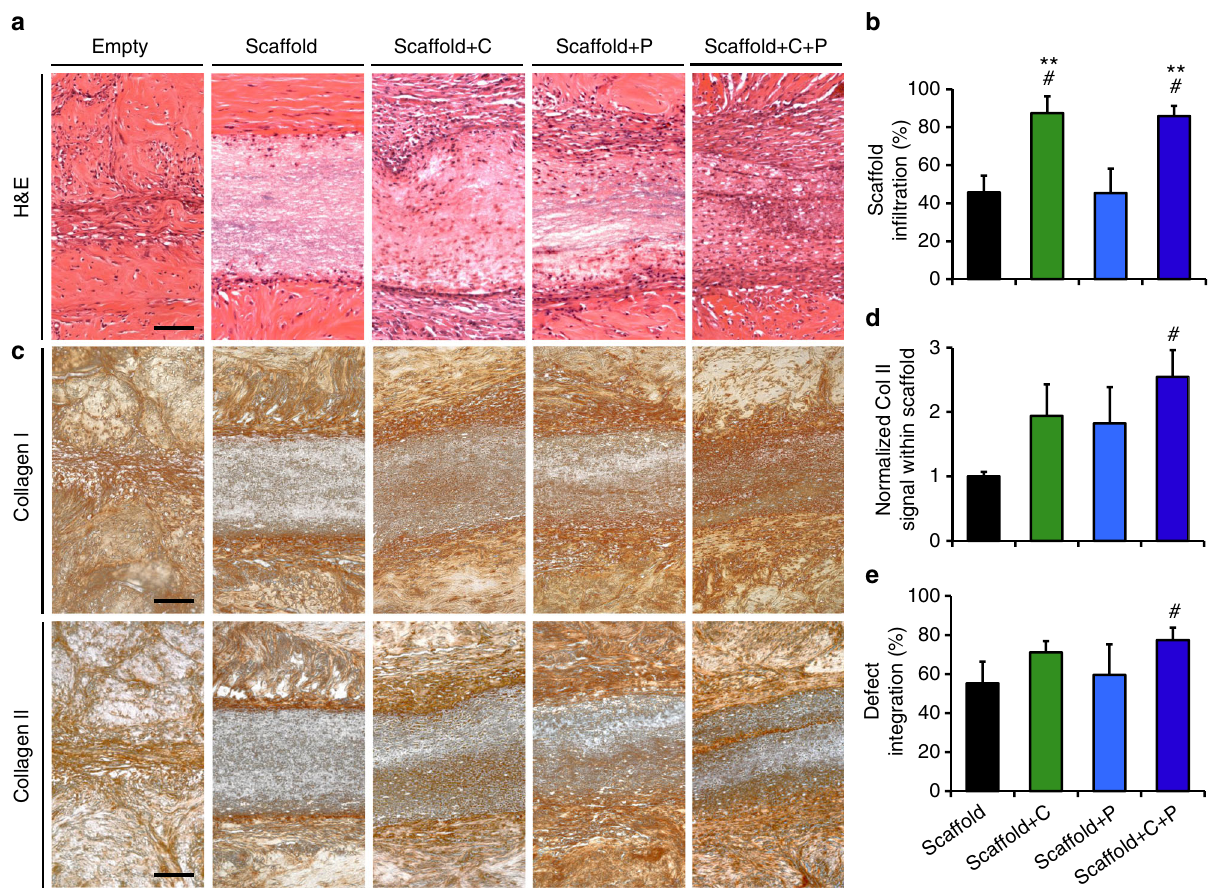
Fig. 7 Scaffolds releasing collagenase and PDGF-AB enhance tissue integration. a Hematoxylin and eosin (H&E) staining of repair constructs show cells, matrix, and nano fi brous scaffolds at the wound site after 4 weeks of subcutaneous implantation. Cells and matrix are observed within the bioactive scaffold groups. Scale = 100 µ m. b Cell in fi ltration into scaffold (% of distance into scaffold center) ( n = 4 – 5 samples/group, mean ± s.d.). c Immunostaining of collagen type I and type II at the wound interface. Scale = 100 µ m. d Average collagen type II signal within the scaffold, normalized to the control Scaffold group ( n = 3 samples/group, mean ± s.d.). e Defect integration (% integrated tissue at the wound site) for scaffold-containing groups ( n = 4 – 5 samples/ group, mean ± s.d.). # = p < 0.05 vs. Scaffold, ** = p < 0.05 vs. Scaffold +